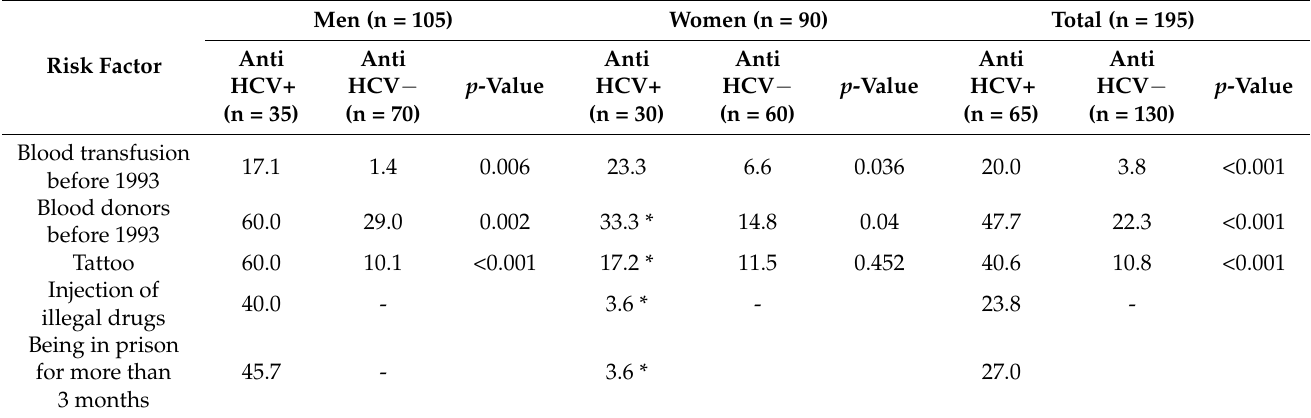
Table 3. Prevalence (%) of possible risk factors for hepatitis C virus infection in seropositive and seronegative